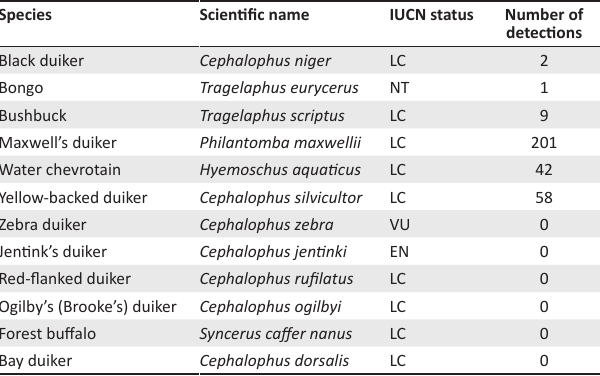
TABLE 1: Potential and observed species of Bovidae and Tragulidae found on and in the vicinity of Tiwai Island, Sierra Leone, using camera traps during 2008–2011.